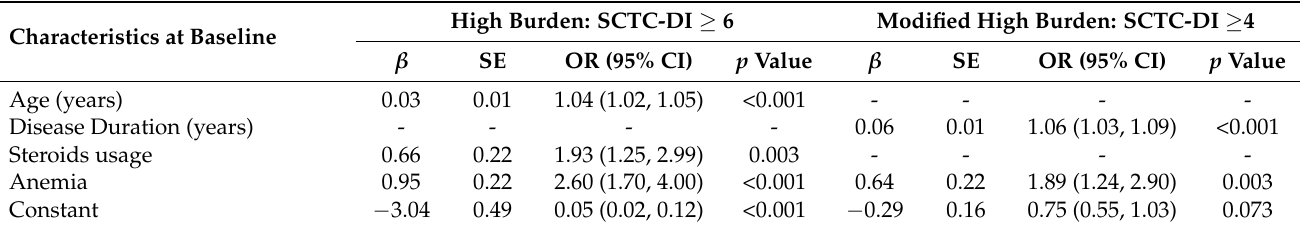
Table 3. Final logistic regression model to identify high-burden organ damage in SSc.